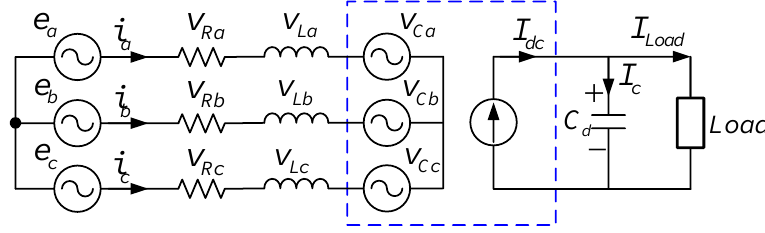
Figure 2. Equivalent circuit of 3-phase AC/DC PWM converter.